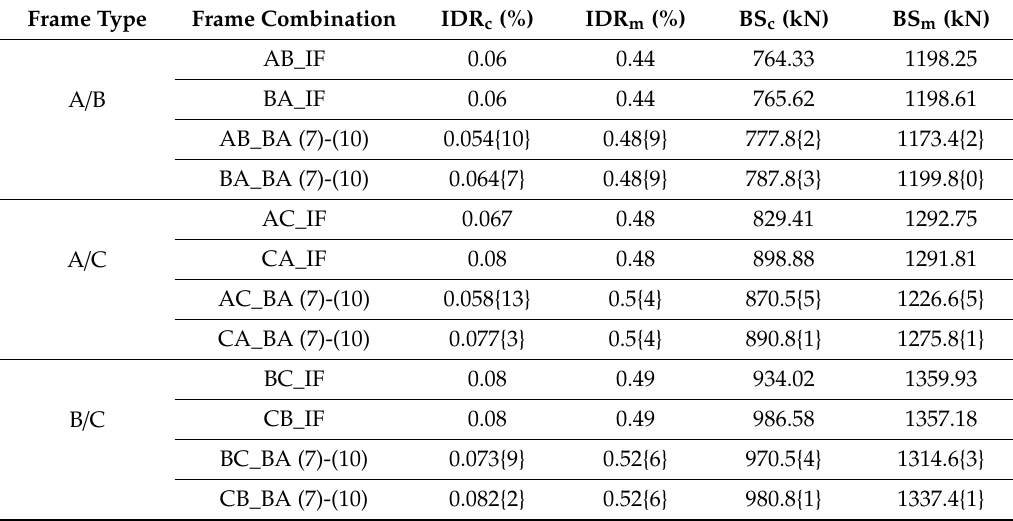
Table 10. Evaluation of accuracy of proposed bilinear approximation equations for di ff erent bay length for frames with two